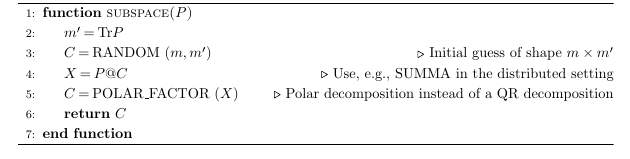
Algorithm 3. Subspace iteration for an m × m projector